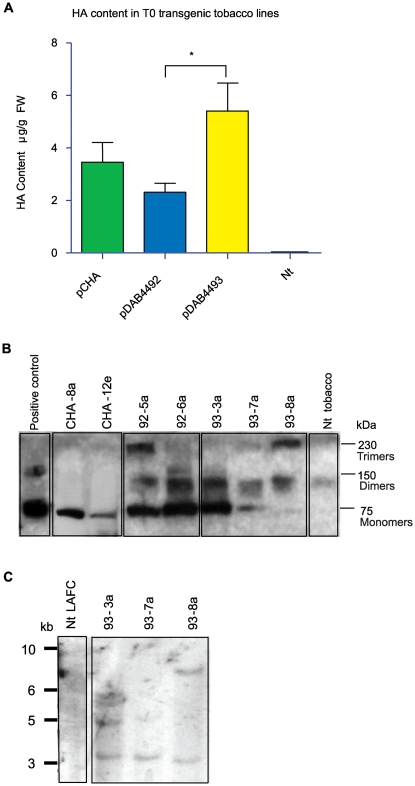
Analysis of T0
N. tabacum LAFC 53 plant lines transformed with HA constructs.2a. The mean HA content in Nt LAFC-HA plants transgenic for each construct type quantified using ELISA analysis. *Mean levels of HA in plants transgenic for pDAB4493 were significantly different (p<0.05; t-test) to those containing pDAB4492. Nt = non-transgenic N. tabacum var. LAFC 53. Error bars represent standard error of mean (SEM) (n = 40 for plants transgenic for pCHA; n = 45 for plants transgenic for pDAB4492; n = 52 for plants transgenic for pDAB4493), FW = fresh weight. 2b. Western analysis of leaf extracts from representative Nt LAFC-HA plants. Extracts from plants containing HA constructs were loaded in central lanes as indicated. Purified HA was loaded as a control in the left lane whilst leaf extract from non-transgenic N. tabacum var. LAFC 53 was loaded in the right lane. All lanes contained 10 µg total soluble protein (TSP). 2c. Detection of HA transgene in selected elite transgenic lines of N. tabacum containing the pDAB4493-HA construct. Southern blot hybridisation of Hind III digested genomic DNA isolated from Nt LAFC-HA transgenic plants probed with the HA gene.